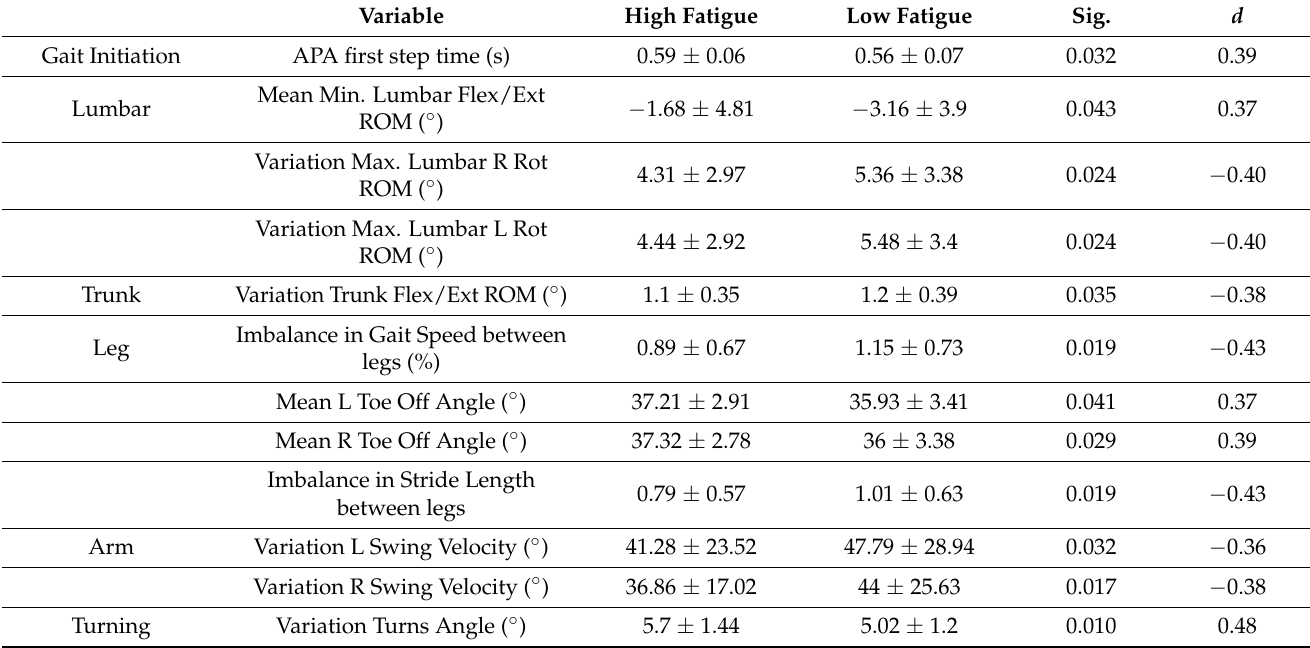
Table 6. Differences between high and low fatigue